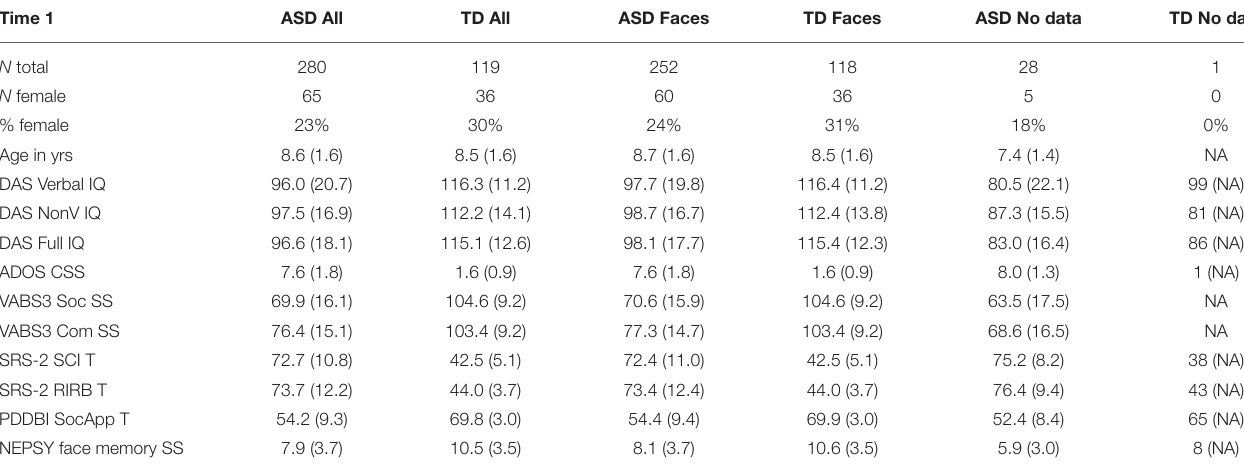
TABLE 1 | Summary of participant characteristics at Time